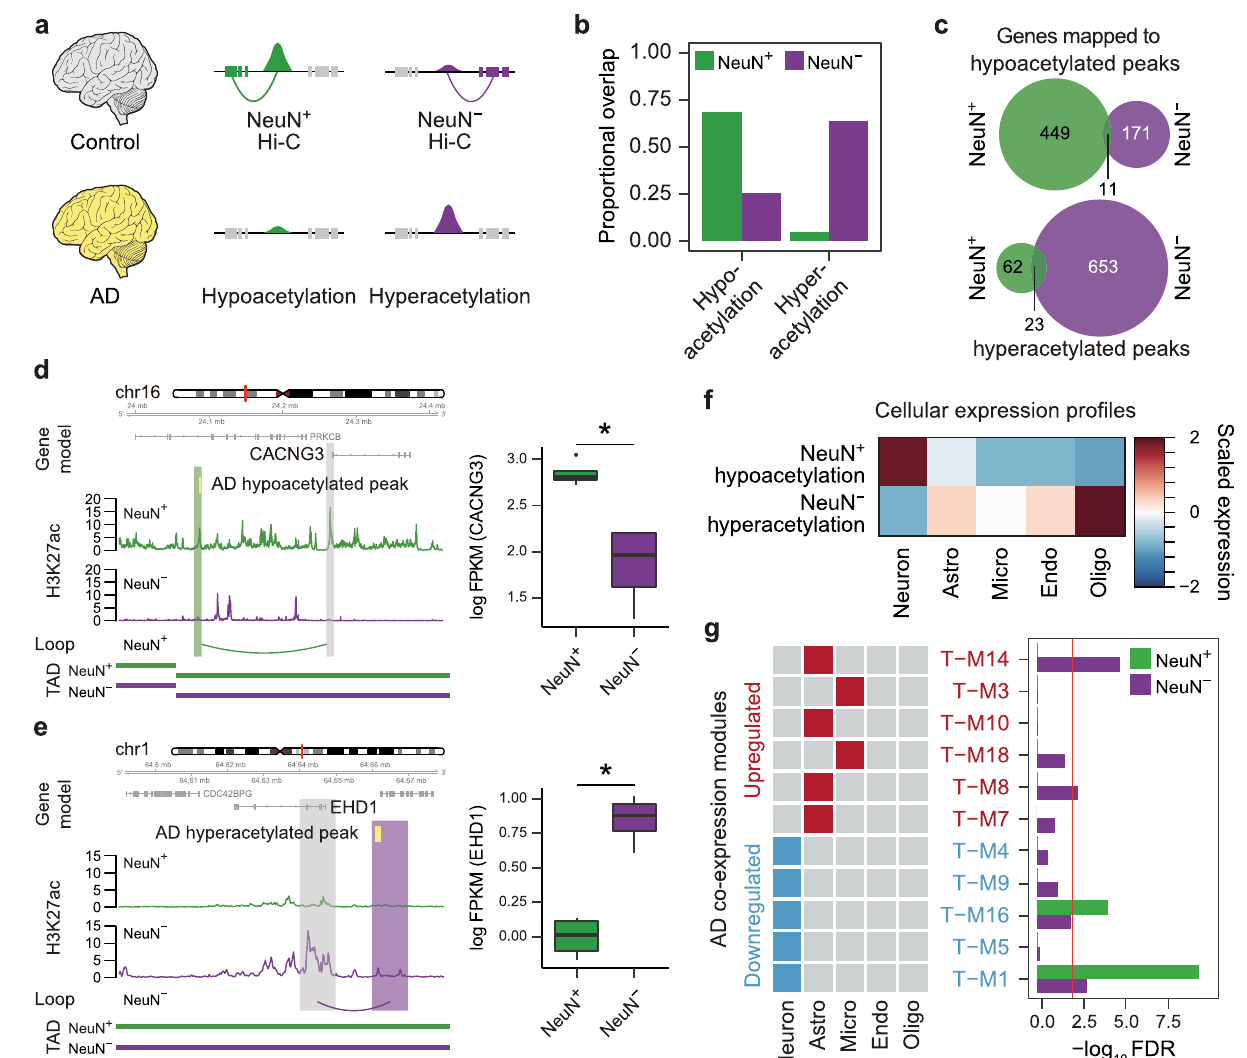
Fig. 3 Cell-type-speci fi c nature of epigenetic dysregulation in AD. a We built AD-associated gene regulatory networks by linking genes to hypoacetylated (hypo) and hyperacetylated (hyper) peaks in AD via Hi – C interactions in NeuN + and NeuN − cells. b AD-associated hyperacetylated peaks were largely active in NeuN − cells, while AD-associated hypoacetylated peaks are largely active in NeuN + cells in neurotypical controls. c The number of genes mapped to AD-associated hyperacetylated (top) and hypoacetylated (bottom) peaks via Hi – C interactions in NeuN + and NeuN − cells. CACNG3 is linked to an AD-associated hypoacetylated peak (marked in yellow) in NeuN + cells ( d ), while EHD1 is linked to an AD-associated hyperacetylated peak (marked in yellow) in NeuN − cells ( e ). CACNG3 / EHD1 promoter is highlighted in gray and its interacting regions are highlighted in green and purple for NeuN + and NeuN − cells, respectively. Boxplots in the right show expression levels of CACNG3 / EHD1 in NeuN + ( n = 4) and NeuN − ( n = 4) cells. FPKM Fragments Per Kilobase of transcript per Million mapped reads. Center, median; box = Q1 – Q3; minima, Q1 − 1.5 × IQR; maxima, Q3 + 1.5 × IQR. *FDR < 0.05 (FDR = 2.81e − 9 for CACNG3 and FDR = 0.004 for EHD1 ), calculated by DESeq2 (two-sided Wald test). Source data are provided as a Source Data fi le. f NeuN + hypoacetylated genes are highly expressed in neurons, while NeuN − hyperacetylated genes are highly expressed in glia. g NeuN − hyperacetylated genes are enriched in astrocyte-speci fi c co-expression modules (T-M14 and T-M8) that are upregulated in AD. NeuN + hypoacetylated genes are enriched in neuronal co-expression modules (T-M1, T-M16) that are downregulated in AD. Fisher ’ s exact test was used for statistical analysis. The red line denotes FDR = 0.01. Astro astrocytes, Micro microglia, Endo endothelial, Oligo